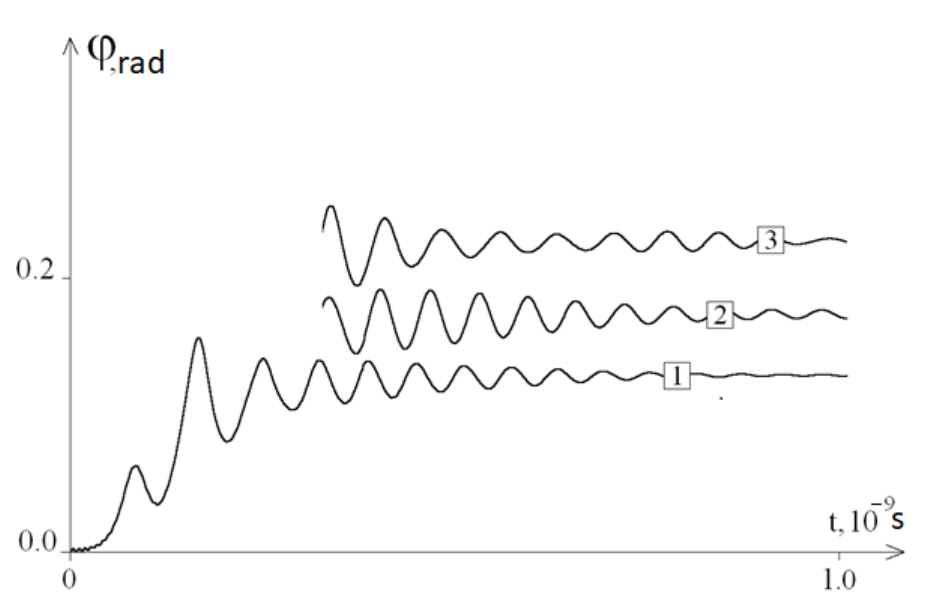
Figure 5. The average angular deviations (with a vertical shift) of the first DNA chain at ω = 10 8 s –1 of the initial DNA (1) and fragments of the graphs for DNA with replacement with (2) 40A, (3) 40 T, (4) 40 G, and (5) 40 C.